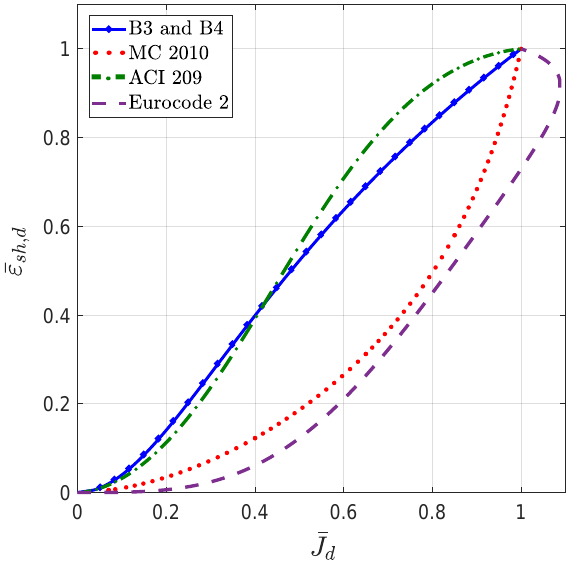
Figure 3. Comparison of normalized drying shrink- age and normalized drying creep evolution according to the selected design codes and prediction models. Normalization is done with respect to the ultimate